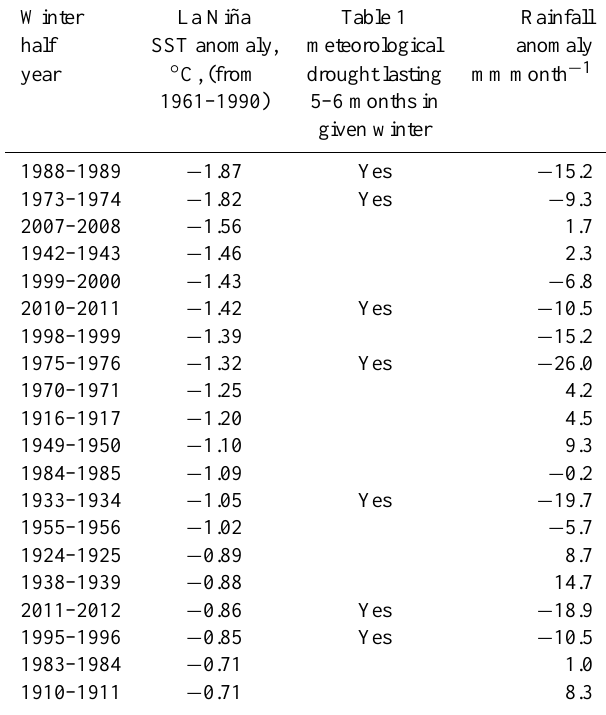
Table 2. Top 20 winter half-year La Niñas and English Lowlands rainfall since 1910–1911, indicating whether these correspond